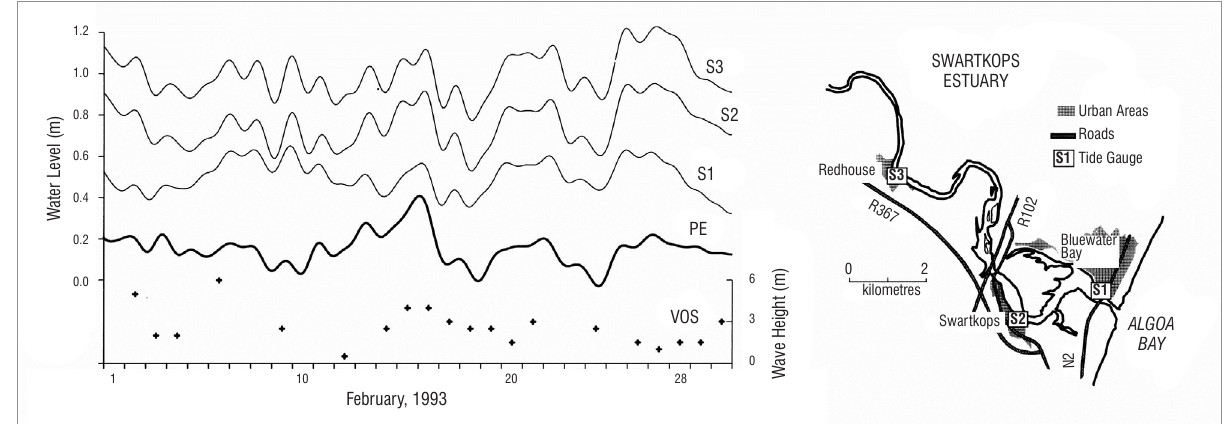
Figure 7: Water levels during February 1993 at three sites in the Swartkops Estuary: S1 at Bluewater Bay, S2 at Swartkops and S3 at Redhouse. Concurrent sea level at the Port Elizabeth harbour (PE) is also given, as well as wave heights (+) reported by voluntary observing ships (VOS).